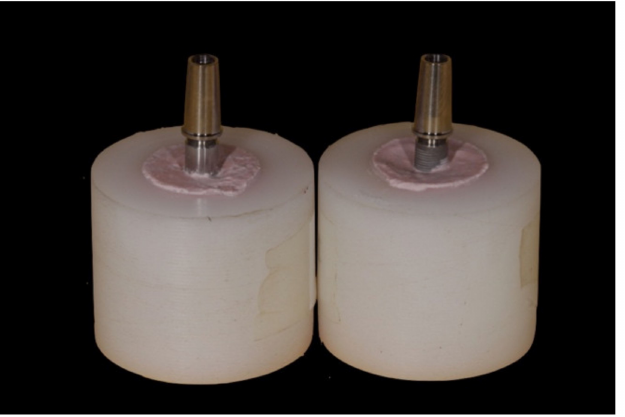
Figure 1. Resin cylinder to standardize the fixation of analogs ( left )/implants ( right ). Each pillar was subjected to the same torque force between the groups: 10 Ncm and 30 Ncm, presenting at the end the following division of groups: group 1 (analog; n = 10): 10 N and 30 N; group 2 (implant; n = 10): 10 Ncm and 30 Ncm. In each group, the abutment was subjected to the torque of 10 Ncm, and the first distance A–B was measured. Then, made (Figure 2).